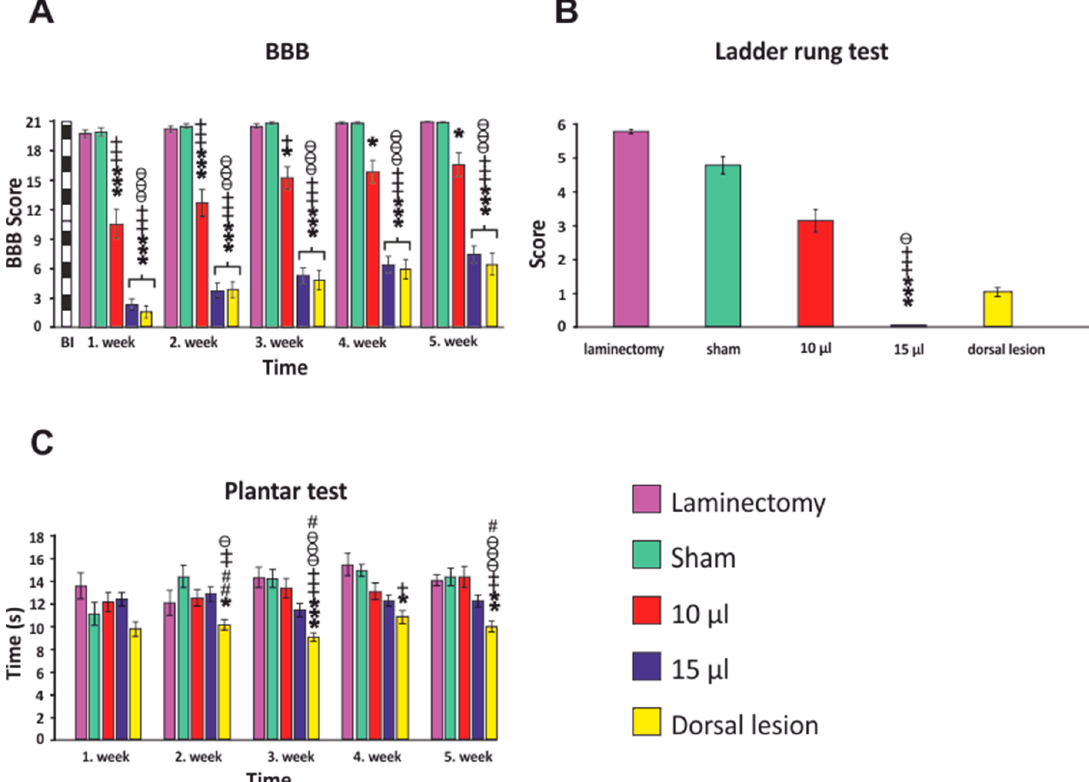
Figure 5. Behavioral assessment of the SCI rats. BBB open field test revealed significant differences between groups. The inflated balloon with 15 μ L both ventrally and dorsally resulted in severe paraparesis with only mild improvement ( A ). Ladder rung score at the fifth week showed a reduced performance in both lesioned groups, where animals in the 15 μ L group were unable to cross the ladder ( B ). Evaluation of the plantar test indicated significant hyperalgesia in the group with the dorsal lesion ( C ). For statistical details, see Table S1, S2, S3 in the supplementary material. Data are expressed as mean ± SEM. * p < 0.05 versus laminectomy; ** p < 0.01 versus laminectomy; *** p < 0.001 versus laminectomy; + p < 0.05 versus sham; ++ p < 0.01 versus sham; +++ p < 0.001 versus sham; θ p < 0.05 versus 10 µ L; θθ p < 0.01 versus 10 µ L; θθθ p < 0.001 versus 10 µ L; # p < 0.05 versus 15 μ L.